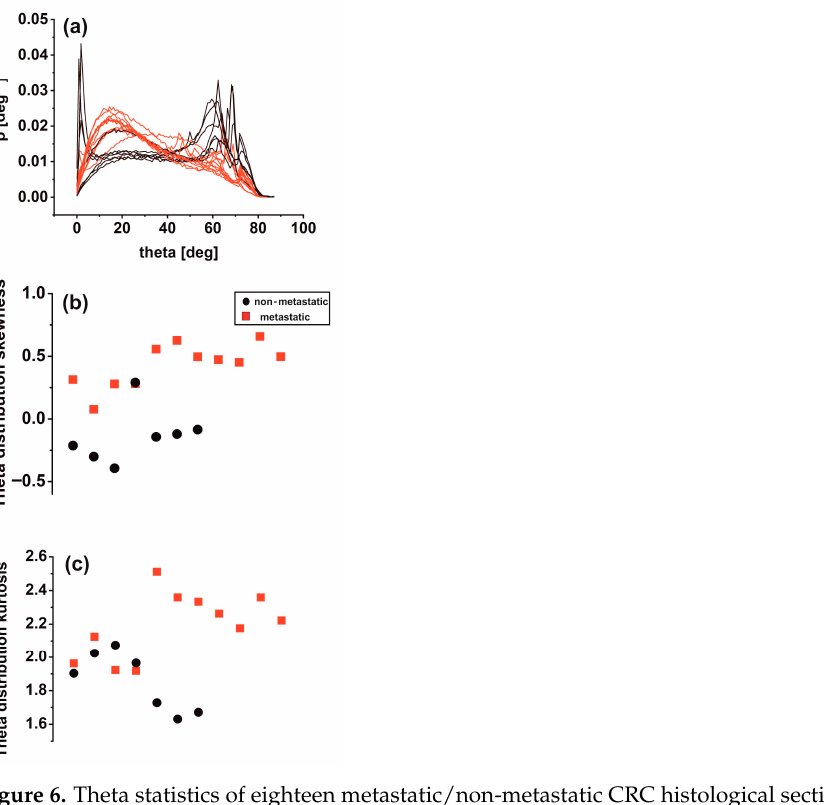
Figure 6. Theta statistics of eighteen metastatic/non-metastatic CRC histological sections. ( a ) Theta spectra of metastatic (red)/non-metastatic (black) sections. The metastatic sections have one max- imum value at 15 ◦ . The non-metastatic sections have two maxima, the first at small angles (2 ◦ ) and the second at high angles (>60 ◦ ). ( b ) Theta distribution skewness of metastatic/non-metastatic CRC histological sections with negative and positive skewness values. One metastatic and non-metastatic point almost coincide. ( c ) Theta distribution kurtosis of metastatic/non-metastatic CRC histological sections.